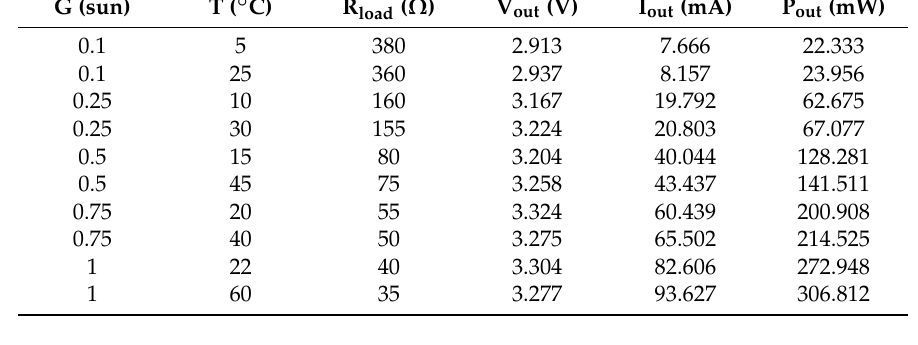
Table 2. Maximum voltage, current and power obtained with simulation under different operation conditions.